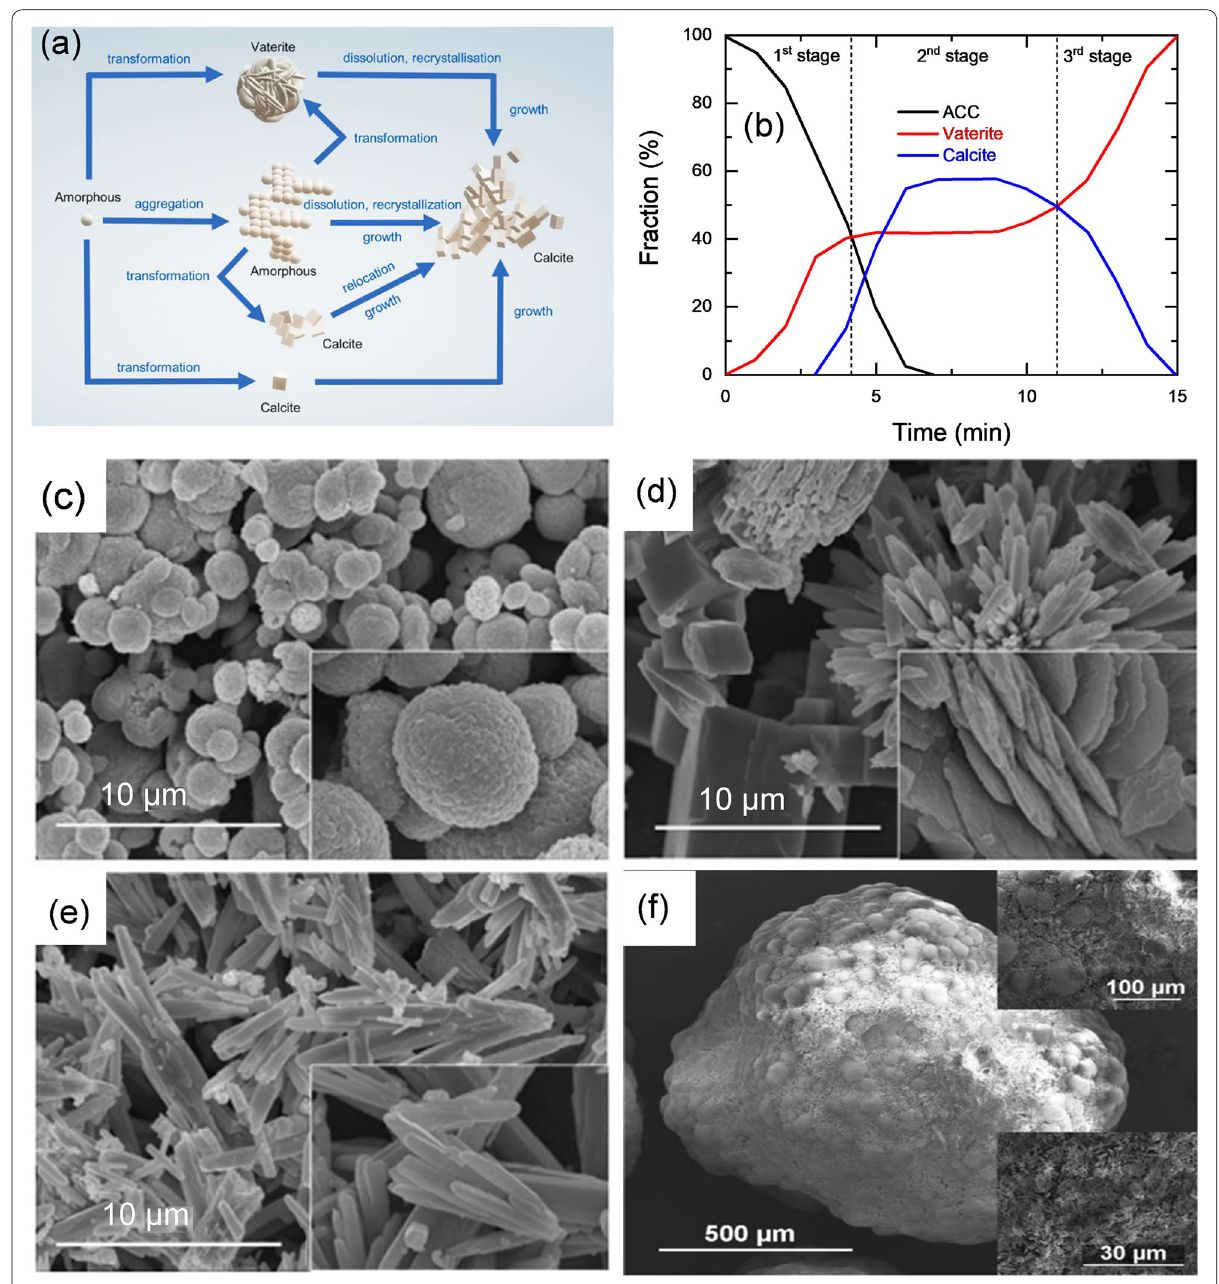
Fig. 9 a Reaction route of the calcium carbonate polymorphs (Adapted from [103] with permission from Elsevier). b Evolution of the calcium carbonate polymorphs (Reproduced from [106] with permission from Elsevier). SEM micrographs of c spherical vaterite, d rosette‑shaped aragonite and cubic calcite, e needle‑like aragonite (Adapted with permission from [107]. Copyright 2017 American Chemical Society), and f granular aragonite recovered in fluidized‑bed reactor (Adapted from [108] with permission from